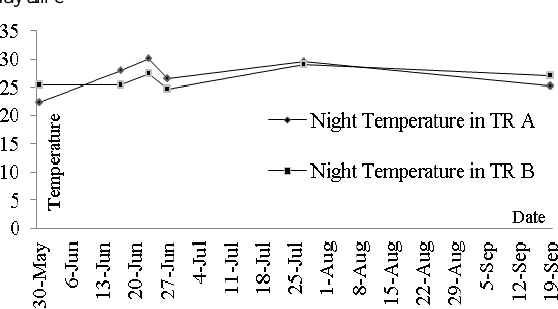
Figure 14: Averaged surface temperature of both treatments in daytime